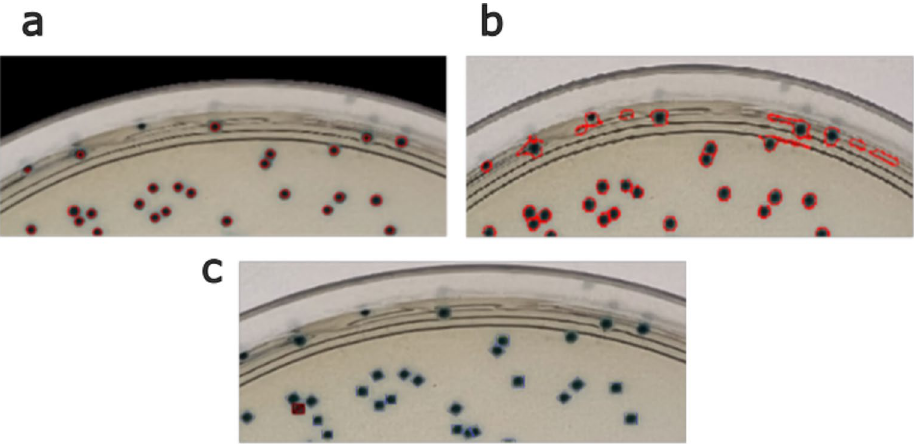
Fig. 4 Comparison of plate border colony detection. a Segmentation results of plate border captured using CFUCounter; b Segmentation results of plate border captured using AutoCellSeg; c Segmentation results of plate border captured using